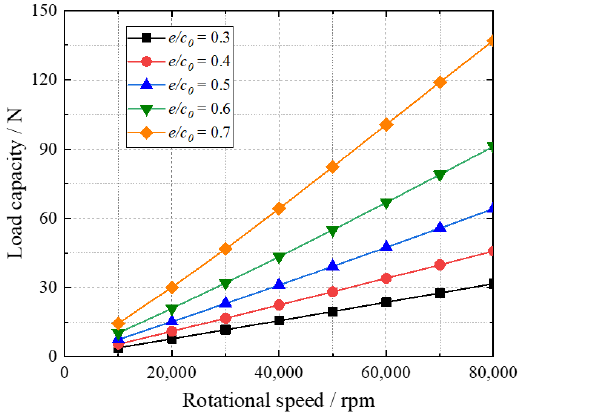
Figure 14. Critical mass of hydrogen gas bearings with gas film clearance.